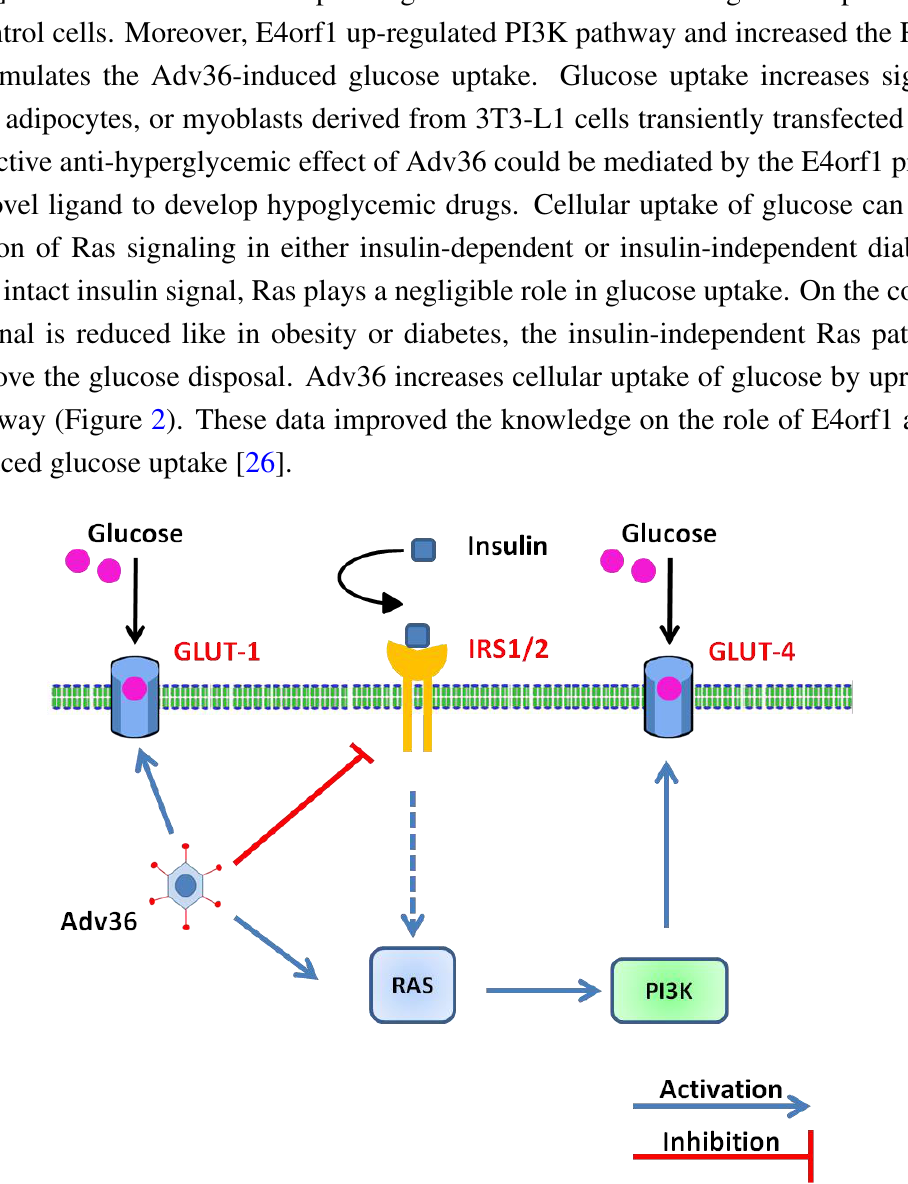
Figure 2. Adv36 mediates glucose uptake independently from insulin, adapted from [64]. Adv36 up-regulates the Phosphoinositide 3-kinase (PI3K) signaling via Ras, increasing cellular glucose uptake by glucose trasporters Glut1 and Glut4 despite a down-regulation of the Insulin Receptor Substrate (IRS) signaling.